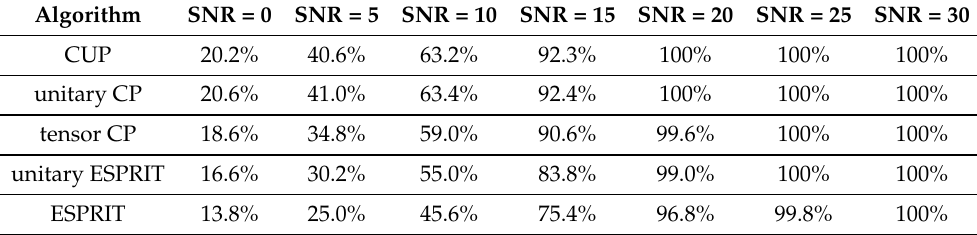
Table 7. PSD of angle estimation versus